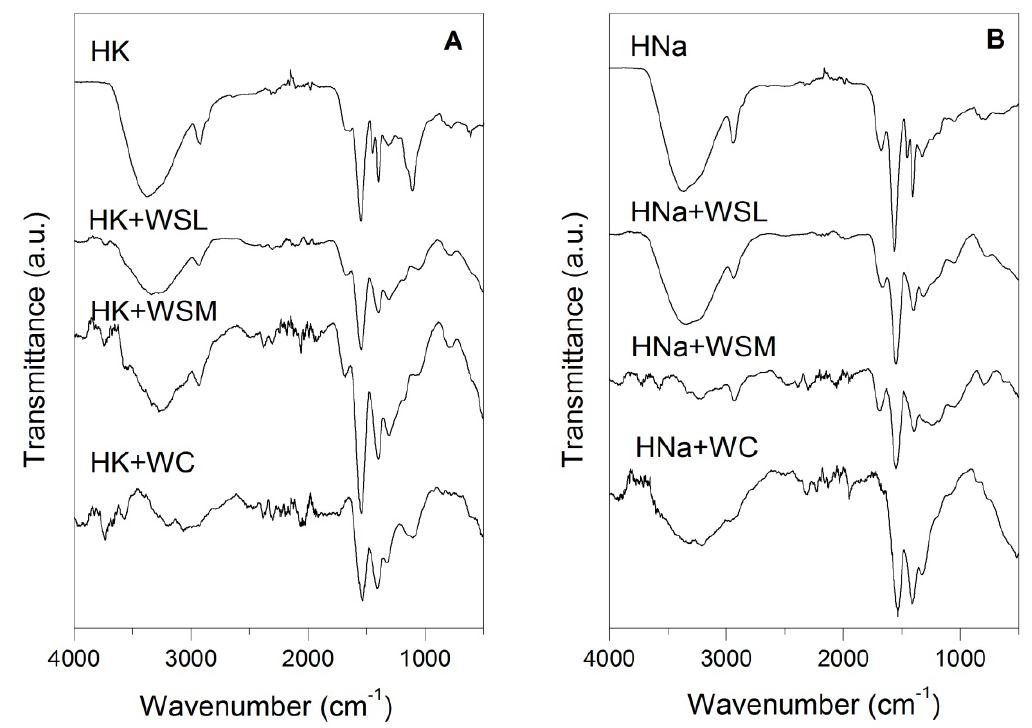
Figure 4. FTIR spectra of hydrogels before and after the swelling process. ( A ) HK and ( B ) HNa.